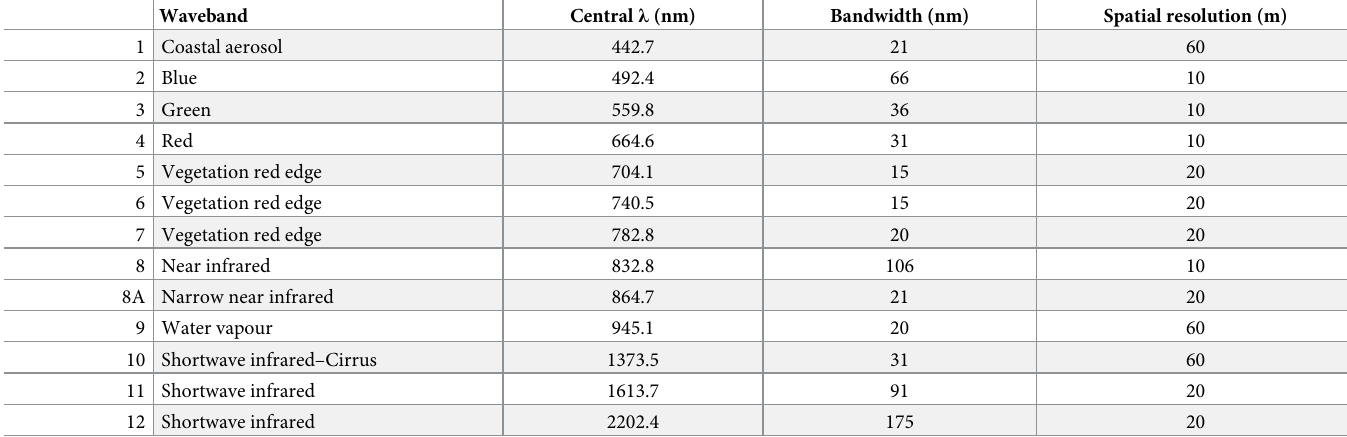
Table 4. Sentinel-2 wavebands showing the central wavelength, bandwidth with the resolution of specific bands that make up the image. Waveband